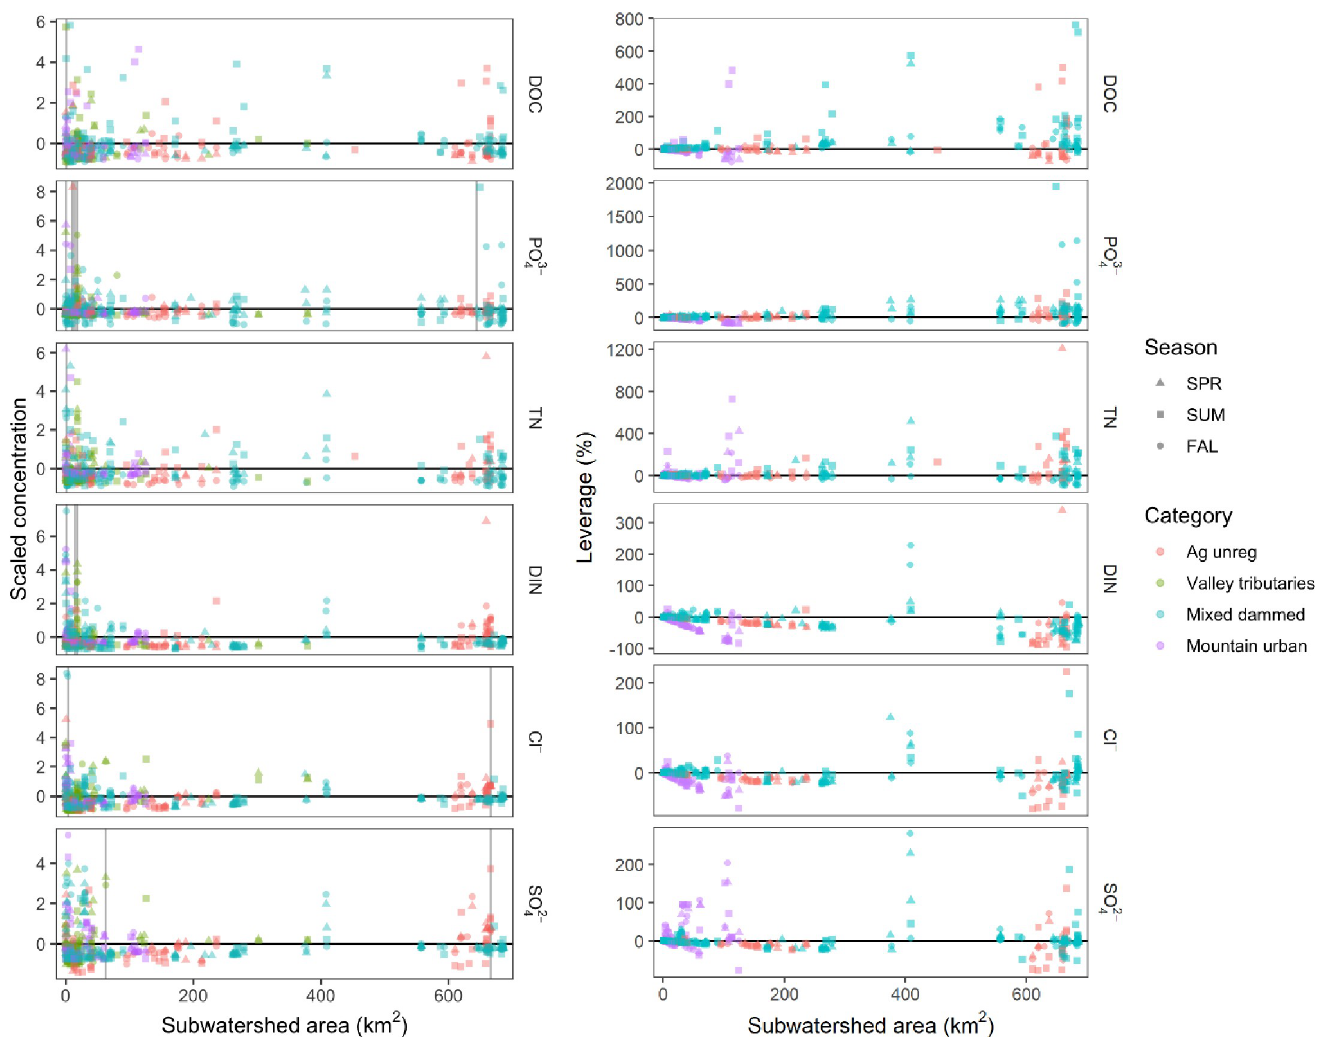
Fig 4. Scaled solute concentration (a, left) and leverage (b, right) by watershed area for solutes of interest (DOC, PO 43- , TDN, DIN, Cl - , and SO 42- ) for sites within four land use and hydrologic categories of the Utah Lake watershed. Samples were collected on synoptic sampling events conducted in three seasons: Spring, Summer, and Fall of 2018. Horizontal lines represent the means of the raw concentration data for that particular solute; vertical lines represent change points detected by PELT